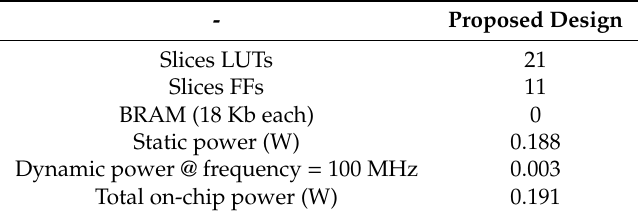
Table 3. Implementation results of the proposed